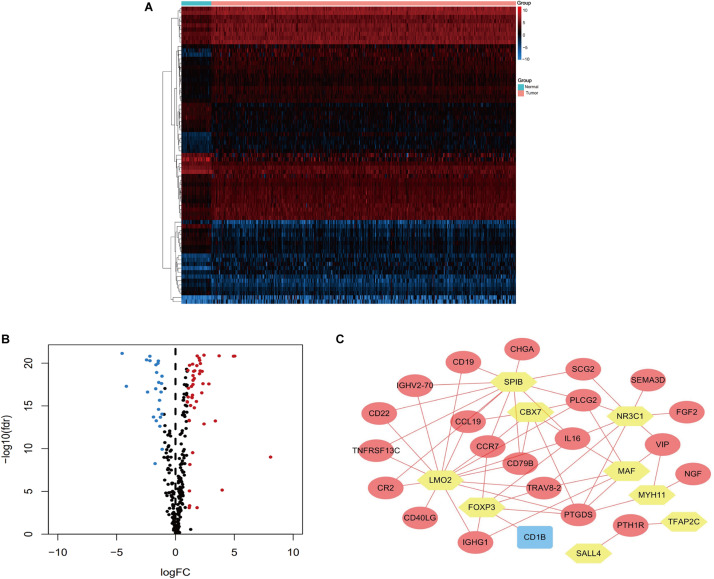
Heatmap (A) and volcano plot (B) showing the differentially expressed TFs between colon cancer and normal colon specimens. Red dots represent upregulated and blue dots represent downregulated differentially expressed TFs, and black dots represent no difference. (C) The intersection of differentially expressed TFs and survival-associated IRGs. Yellow hexagons represent TFs. Rectangles and ovals represent IRGs.